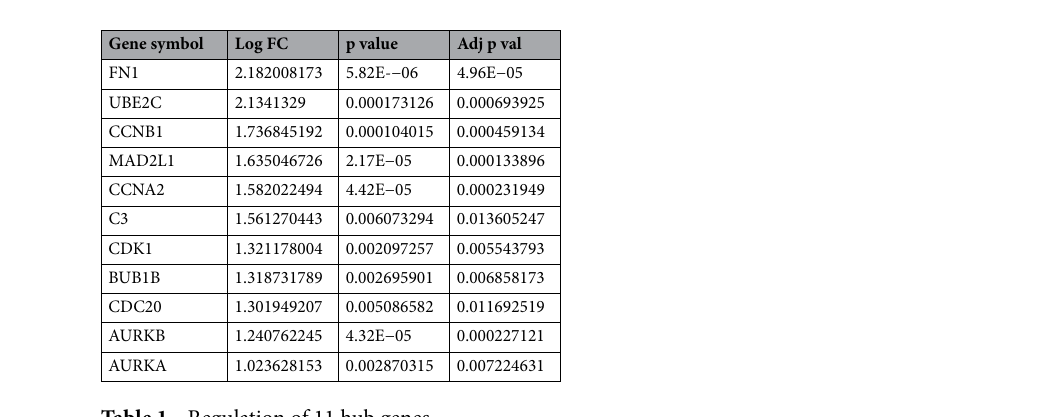
Table 1. Regulation of 11 hub